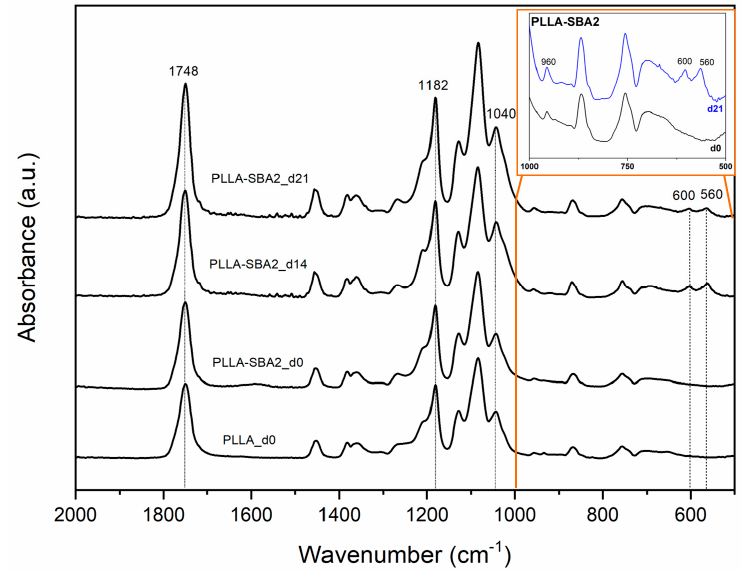
Figure 7. Fourier transform infrared (FTIR) spectra of neat PLLA (PLLA_d0) and composite scaffolds (PLLA-SBA2_d0) before incubation in simulated body fluid (SBF) and of composite fibres after 14 (PLLA-SBA2_d14) and 21 days (PLLA-SBA2_d21) of incubation in SBF. The inset better